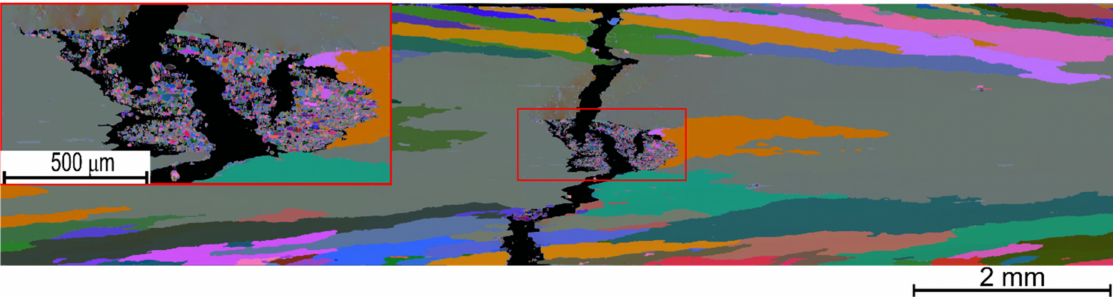
Figure 7. An Euler color EBSD map of Fe-10Al-4Cr-4Y 2 O 3 ODS specimen with 1.25 Y show- ing coarse-grained microstructure and mixed trans/inter-crystalline fracture initiated in the soft unrecrystallized